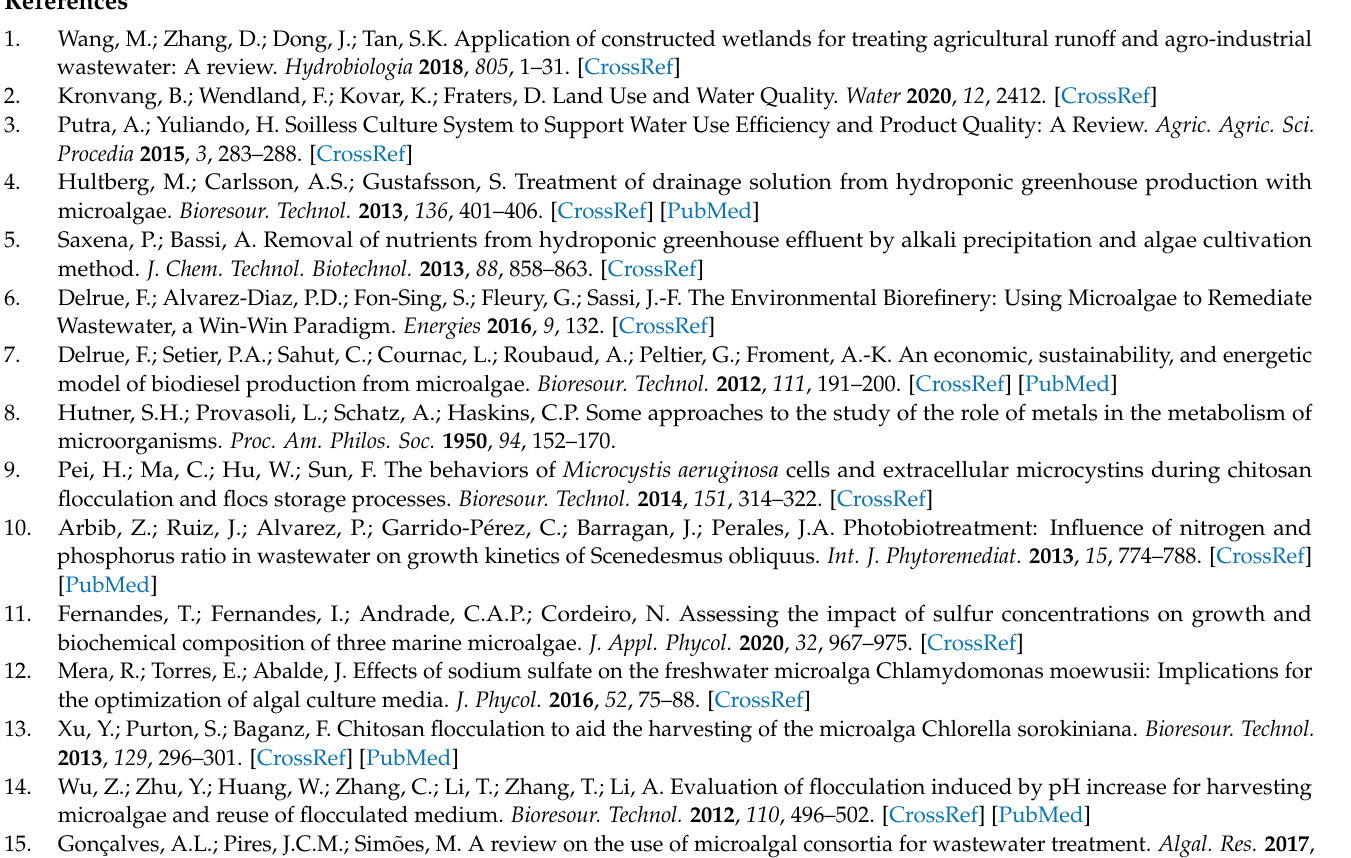
Figure A8. Chitosan coagulation efficiency for the culture of HFWWC grown in HFWW after each of the three cycles of the experiment of the continuous integrated process experience.